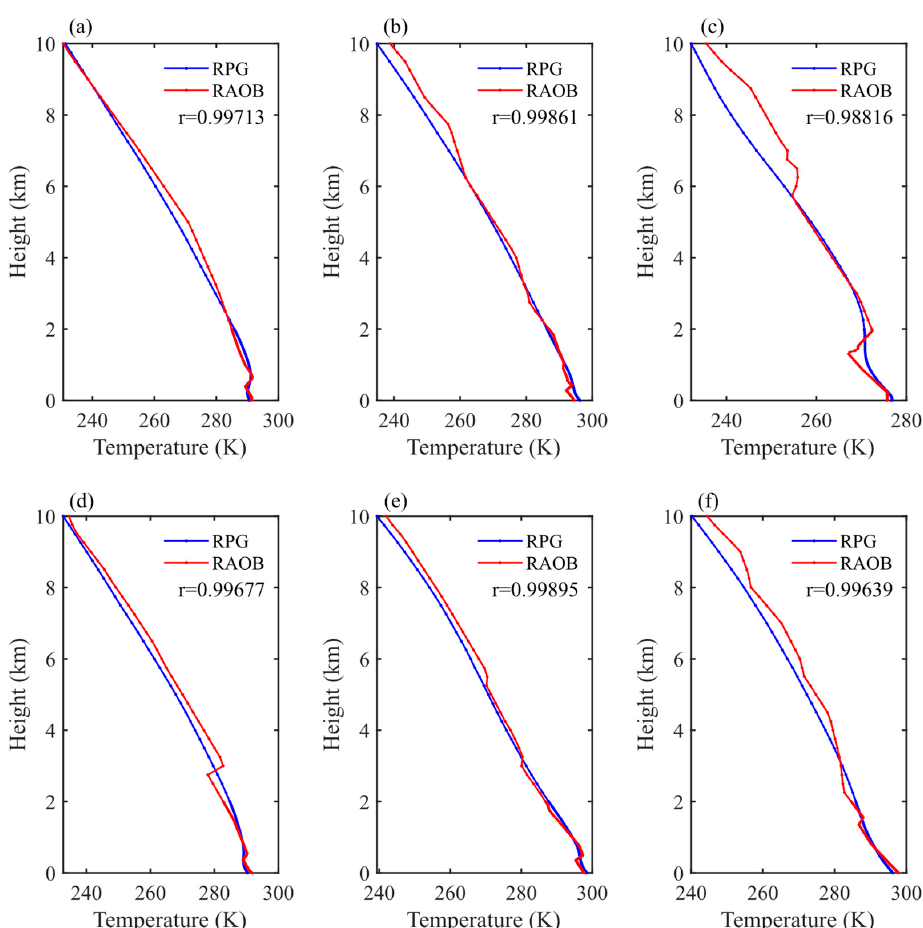
Figure 9. Temperature profiles in various weather conditions, where the blue line and the red line represent the MWR retrieval profiles (RPG) and the radiosonde observation profiles (RAOB), respectively. Temperature profiles observed at 1200 UTC on 17 April 2019 ( a ), 0000 UTC on 15 June 2019 ( b ), 0000 UTC on 27 December 2019 ( c ), 1200 UTC on 24 April 2019 ( d ), 0000 UTC on 16 June 2019 ( e ), and 1200 UTC on 18 September 2019 ( f ).